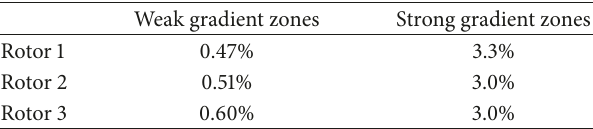
Table 3: Relative measurement uncertainties for high frequency static pressure measurements estimated for CREATE by